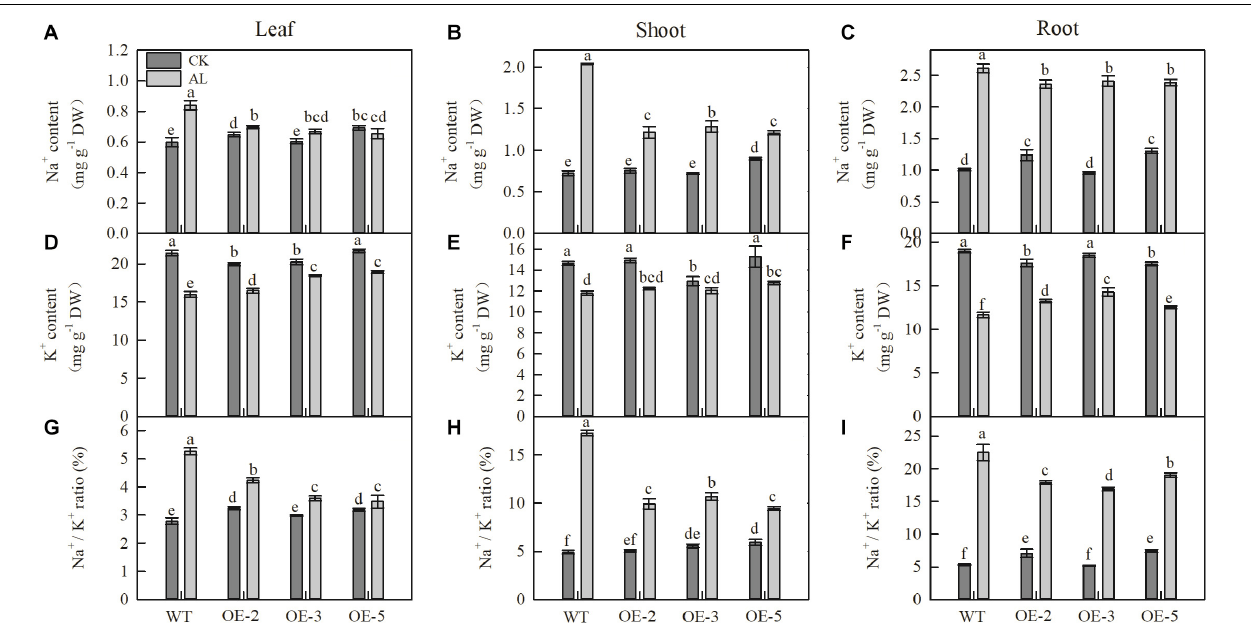
FIGURE 5 | MdTyDc overexpression changed the Na + and K + content in apple plants after 15 days under control and alkaline conditions. (A) Leaf Na + content, (B) shoot Na + content, (C) root Na + content, (D) leaf K + content, (E) shoot K + content, (F) root K + content, (G) leaf Na + /K + ratio, (H) shoot Na + /K + ratio, and (I) root Na + /K + ratio. The data are presented as means ± SD ( n = 3). Significant differences between WT and MdTyDc overexpression lines are indicated by different lowercase letters based on Tukey’s multi-range test ( P < 0.05). WT, wild type. OE-2, MdTyDc overexpression line 2. OE-3, MdTyDc overexpression line 3. OE-5, MdTyDc overexpression line